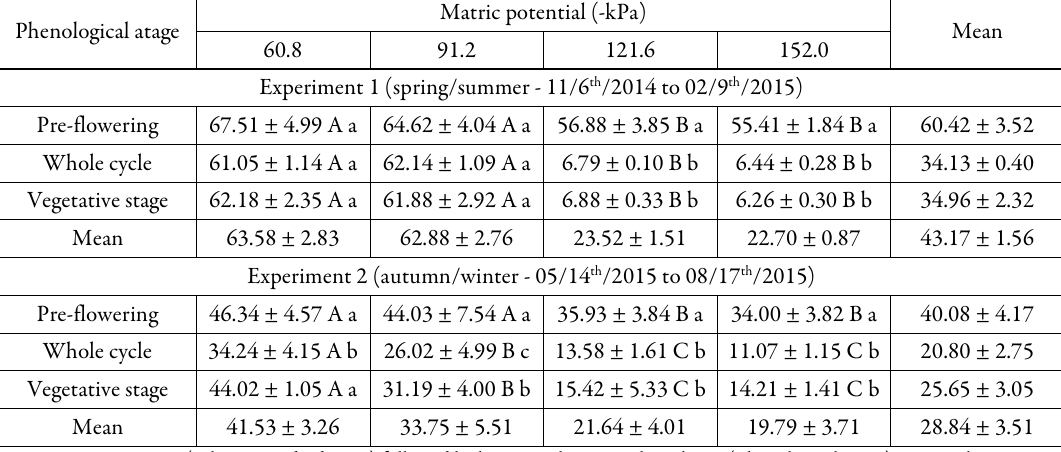
Table 1. Origanum vulgare L. fresh biomass production within the experiments Phenological atage